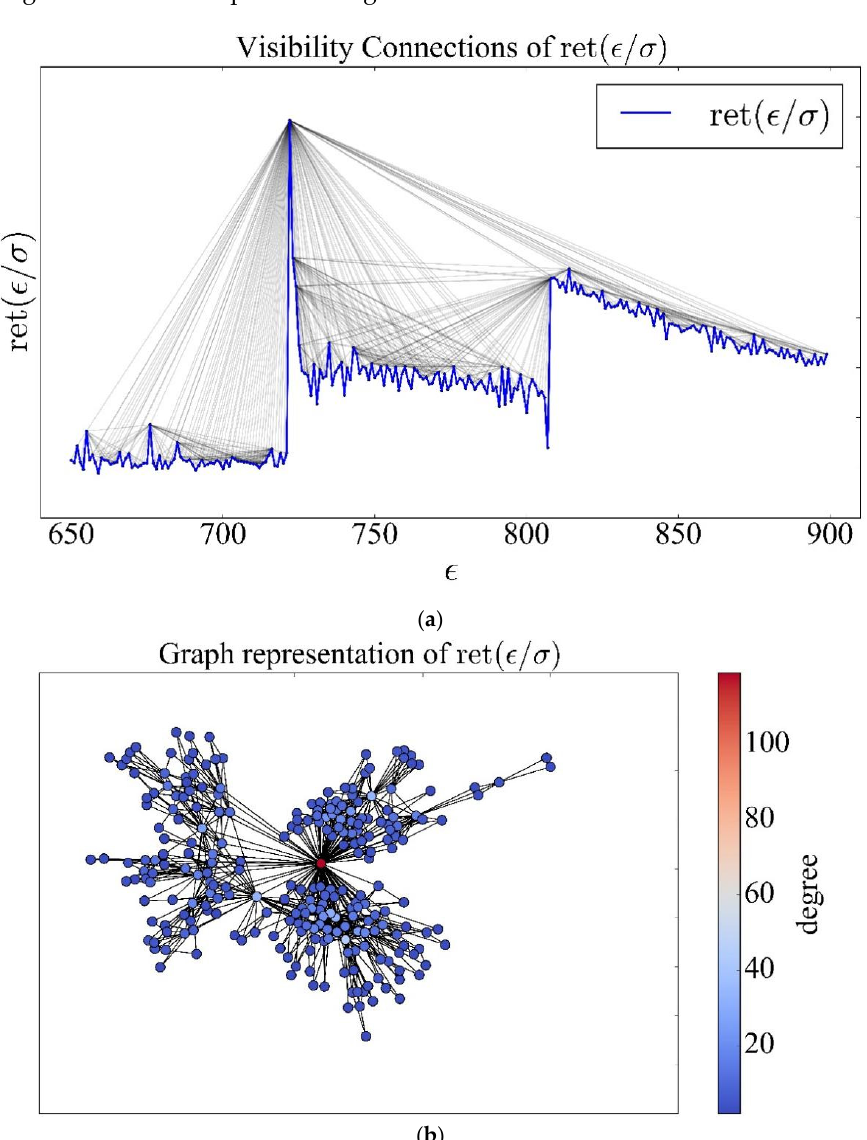
Figure 2. The visibility connections based on the VG approach during the stage of the transition from elastic to plastic regime ( a ). The graph representation of the studied fragment with the empha- sized degree connection for each element ( b ). degree connection for each element ( b